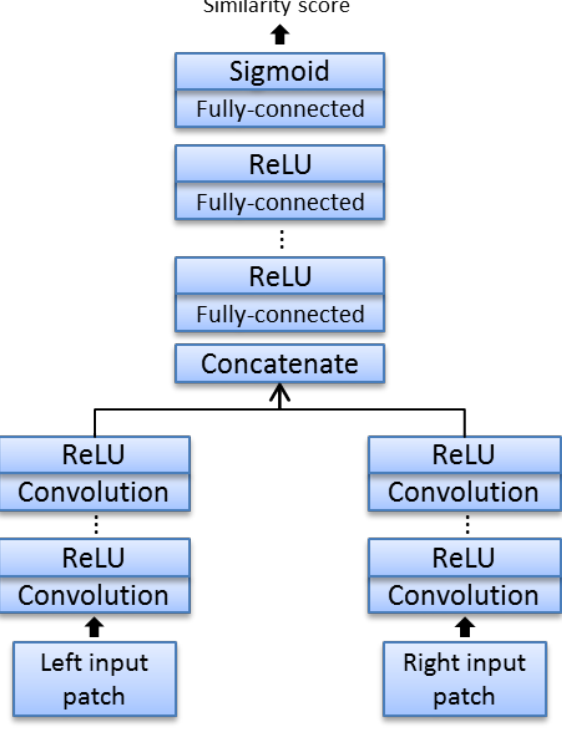
Figure 2. The accurate architecture to calculate matching cost